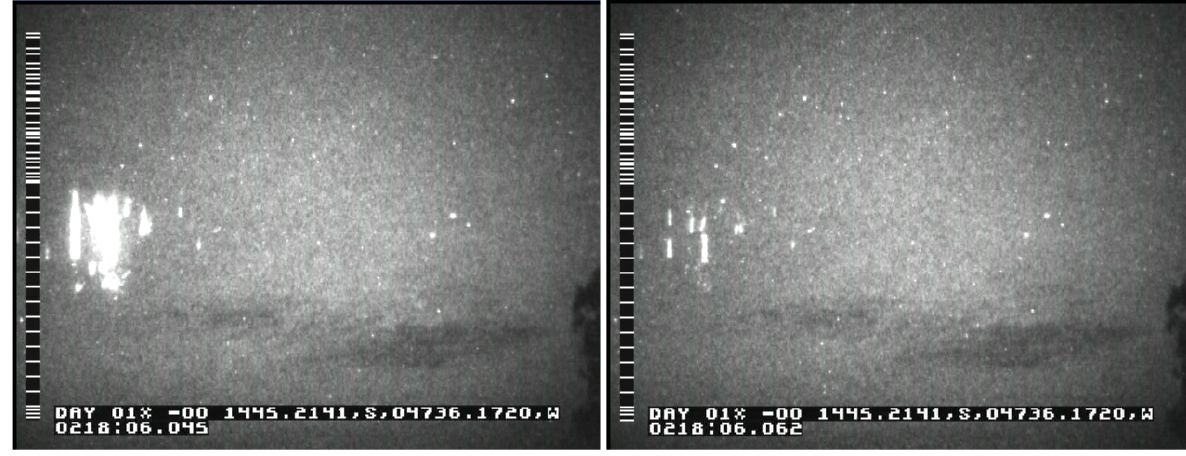
Fig. 7. A second sprite group that lasted one frame, i.e. 33ms, observed above the same